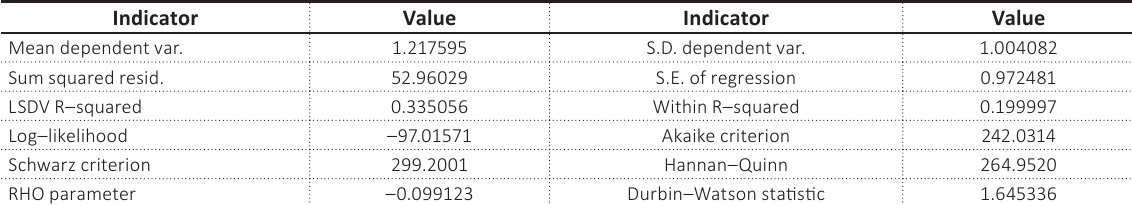
Source: Calculated via Gretl software